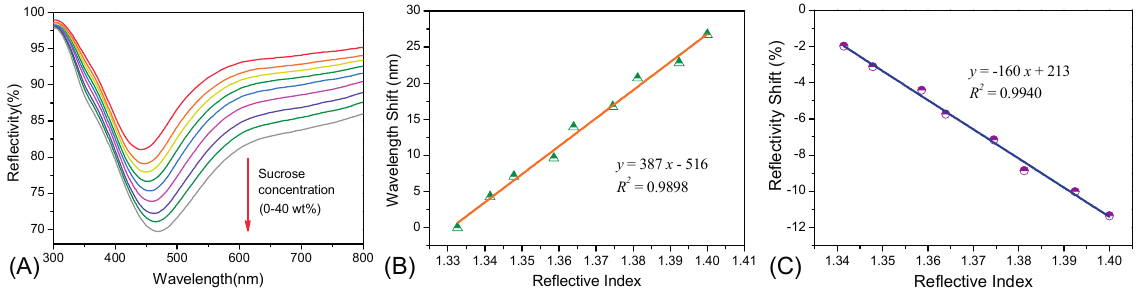
Figure 3. ( A ) The reflective spectra of the Ag NP-based sensors of sucrose solutions with different concentrations; ( B ) Changes in the LSPR wavelength shift to the refractive indices; ( C ) Changes in the LSPR reflectivity shift to the refractive